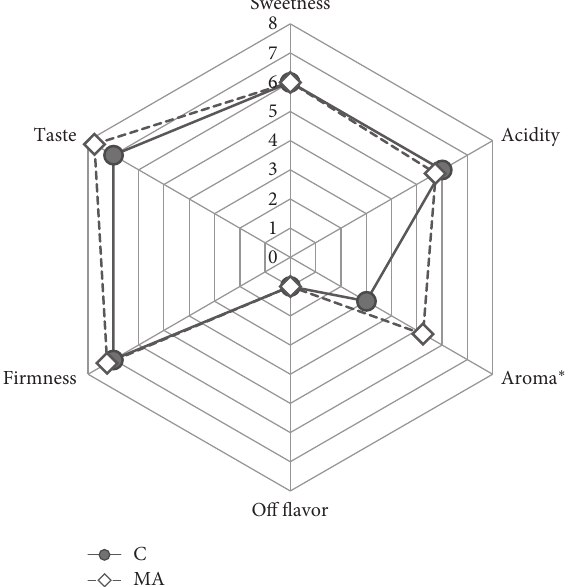
Figure 2: Sensory analysis of untreated (C) and treated ( O. ficus- indica mucilage in combination with ascorbic acid-MA) strawberry “Fortuna” fruit, after 3 days of storage at 4 ° C. Data are mean of 15 fruit for each treatment. ∗ Significant differences for values (Tukey’s test at p < 0 . 05).